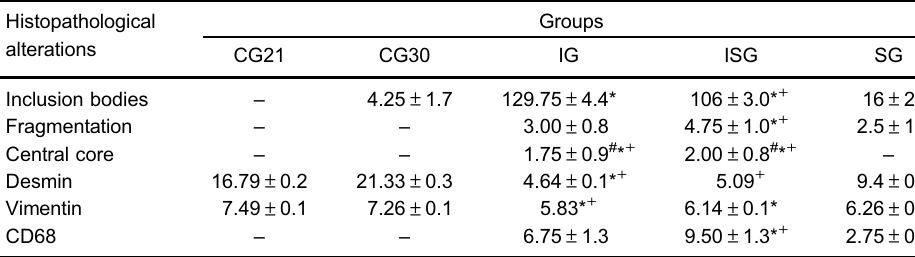
Table 1. Histopathological alterations in the soleus muscle fi bers quanti fi ed based on conventional staining and immunoreactivity (desmin, vimentin, and CD68).